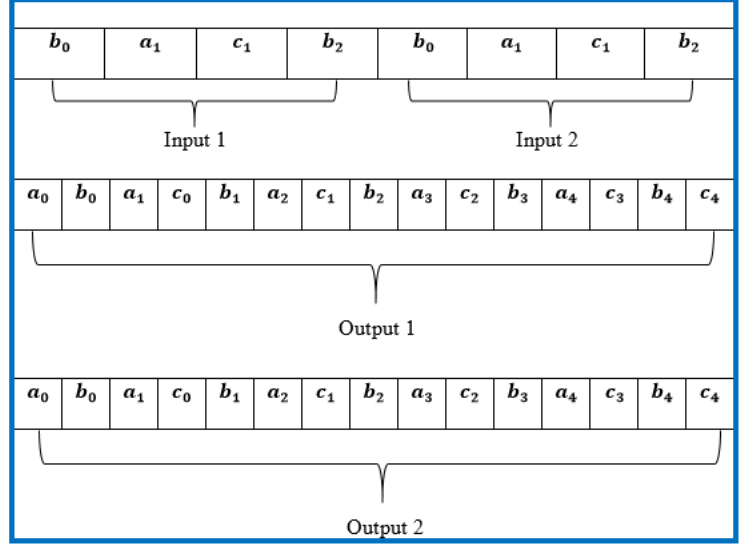
Figure 5. Vector for the optimization optimized fuzzy differential evolution (OFDE) and optimal fuzzy harmony search (OFHS).